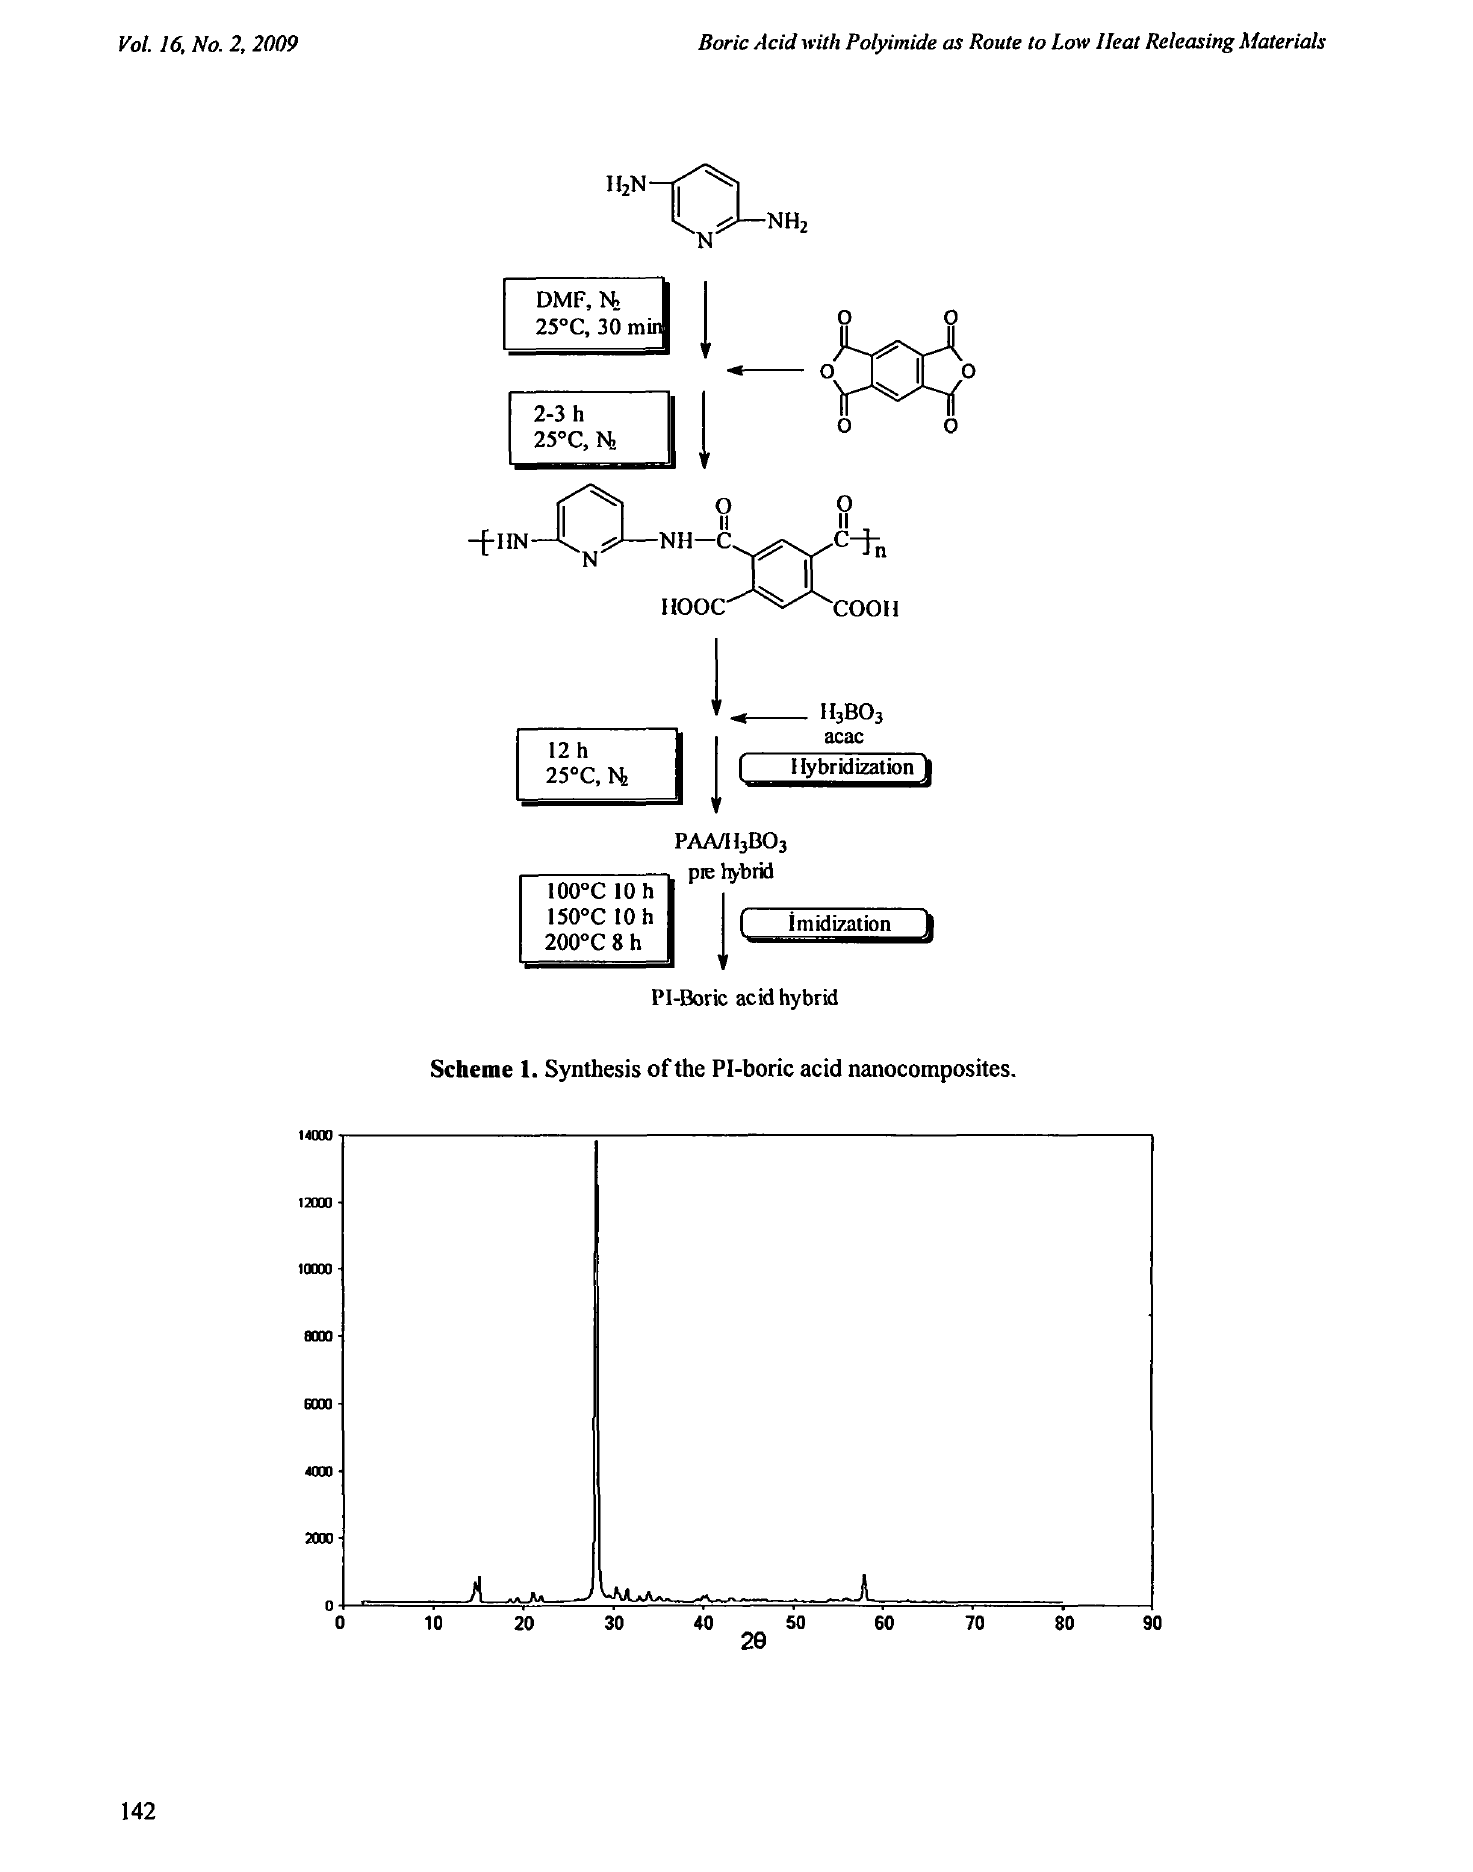
Scheme 1. Synthesis of the Pi-boric acid